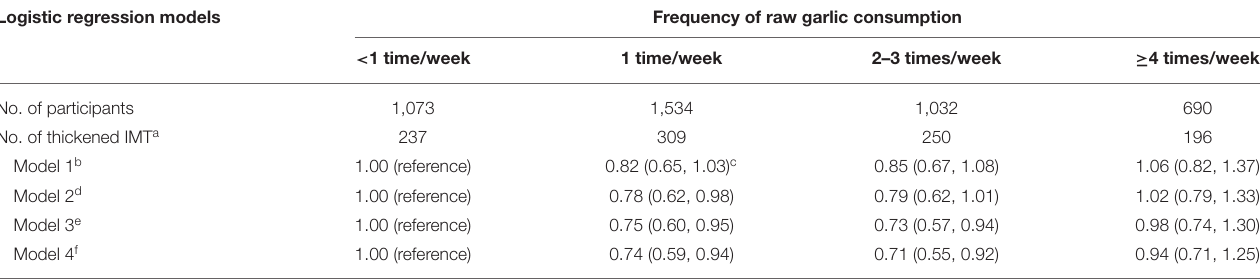
TABLE 3 | Multivariate adjusted odds ratios for thickened cIMT a according to frequency of raw garlic consumption among Chinese adults, the Tianjin Chronic Low-grade Systemic Inflammation and Health Cohort Study. Logistic regression models Frequency of raw garlic consumption < 1